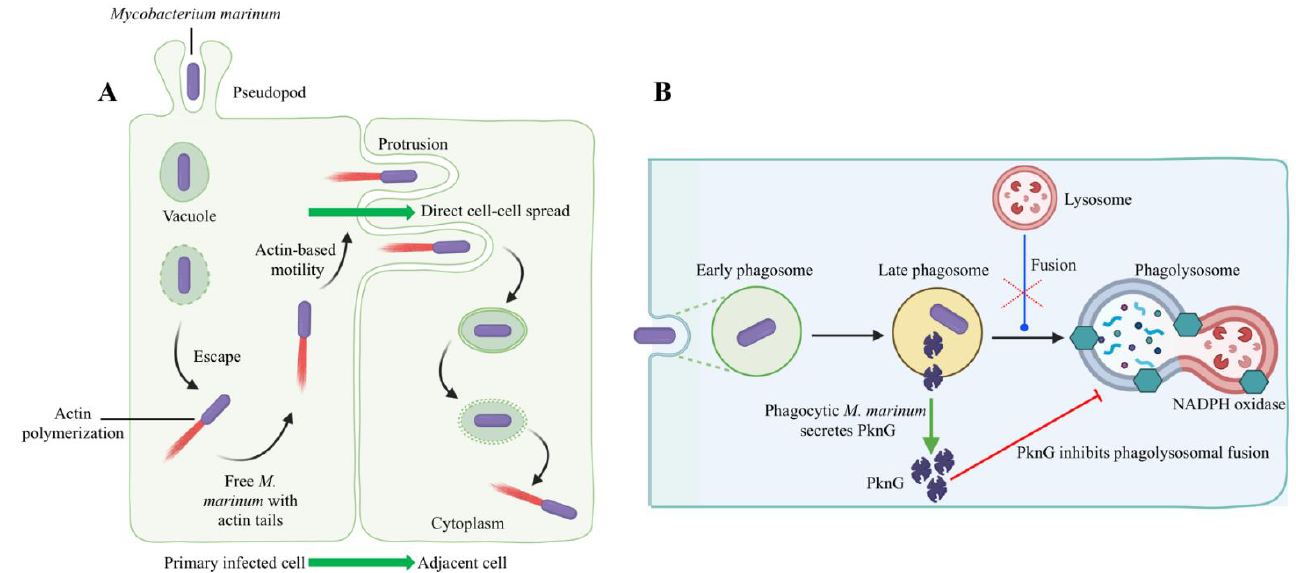
Figure 5. Host–pathogen interactions during intracellular evasion strategies of M. marinum . M. marinum has been shown to use two methods to evade phagocytic killing: ( A ) Escape from phagosomes into the cytosol and cell-to-cell spread via actin-based motility [123]. The initial uptake of M. marinum into phagocytic vacuoles is followed by an escape from vacuoles into the cytoplasm. According to Stamm et al. (2003), M. marinum polymerized actin through the recruitment of host cell cytoskeletal factors in the cytoplasm [112]. Thus, free M. marinum with actin tails was observed in the host cell cytoplasm. The acquisition of actin-based motility allows M. marinum to spread cell to cell directly from primarily infected cells to adjacent cells without leaving the cytoplasm. ( B ) M. marinum blocks phagolysosomal fusion (late phagosome fused with phagocytic lysosome), thus resisting the discharge of lysosomal contents into the phagosome. Here, protein kinase G (PknG) secretion through the SecA2 pathway is initiated by phagocytic M. marinum . Secreted PknG directly inhibits the fusion of late phagosomes with lysosomes. This original illustration was generated by the authors using BioRender (https://biorender.com/) (accessed on 16 November